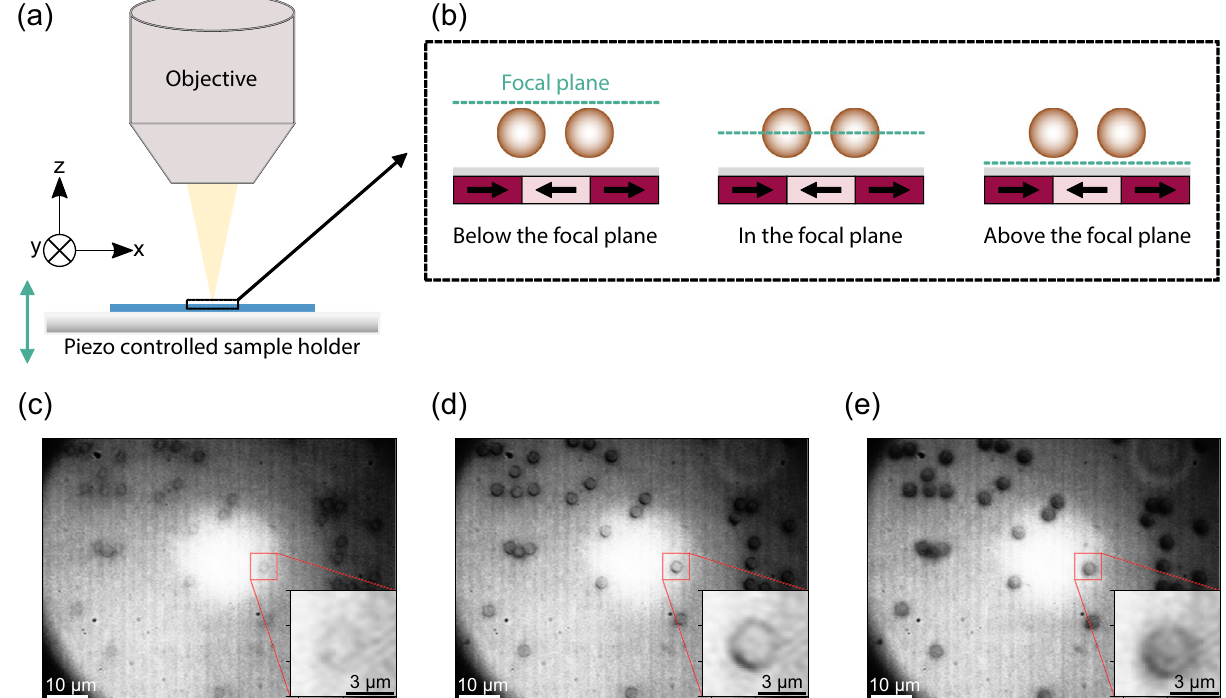
Figure 1. Acquisition of in and out of focus bright-field microscope images for axial position determination of SPPs. ( a ) Sketch of a focus sweep procedure. ( b ) SPPs are trapped within the local MFLs above a magnetic substrate with hh/tt magnetized stripe domains (indicated by black arrows). SPPs are moved from a position below the focal plane ( c ), through the focal plane ( d ) to a position above it ( e ). Exemplary